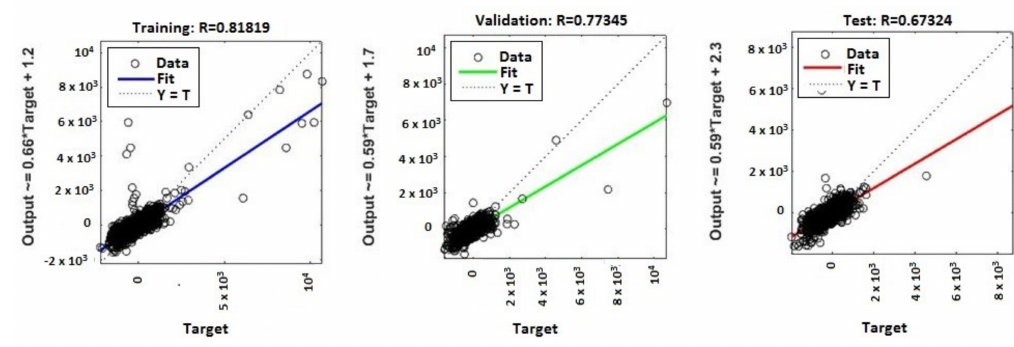
Figure 12. Regression ( R 2 ) for validation, test, and training—ANN with 150